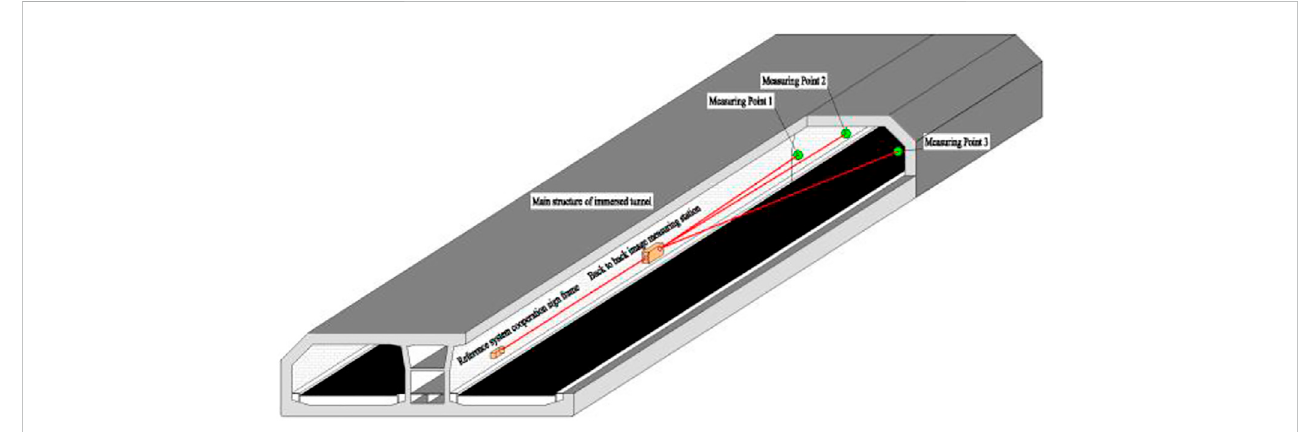
FIGURE 4 Layout and installation diagram of monitoring